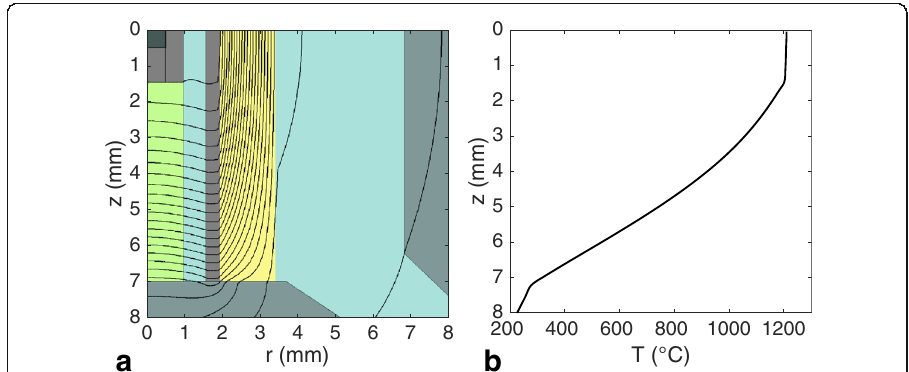
Fig. 8 a The temperature distribution in the assembly, as modelled with the numerical model of Hernlund et al. [43]. Constant colour areas are indicative of sample (black), graphite (grey), Al 2 O 3 thermocouple tubing (green), MgO (cyan), Zr 2 O 3 (yellow) and WC cubes (darkish cyan). Black contours lines represent isotherms separated by 50 degree intervals, with the 1200 °C isotherm located closest to the sample (at z = 1.5 mm and r = 0 mm). b The modelled temperature profile along the assembly ’ s axis (the r = 0 line)